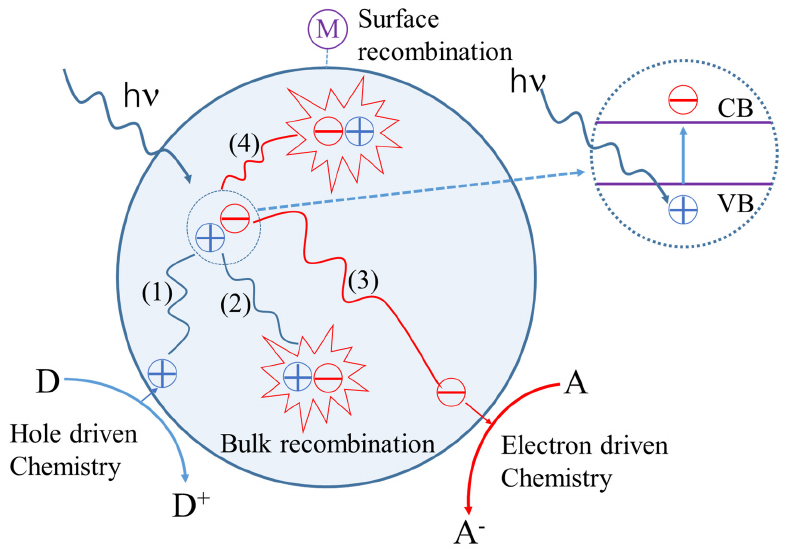
Figure 3. Photocatalytic mechanism associated with TiO 2 .